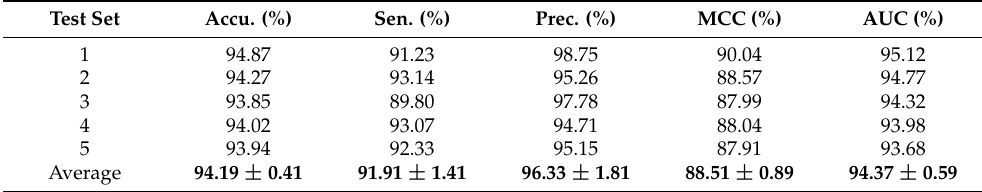
Table 2. MSPEDTI outcomes for 5CV on enzyme dataset.